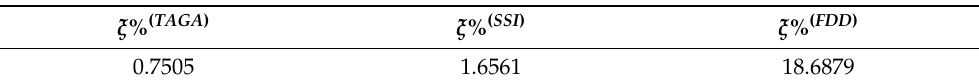
Table 5. Discrepancy between the estimated FRFs matrix in nodal space and the exact one for the 3DoF system.